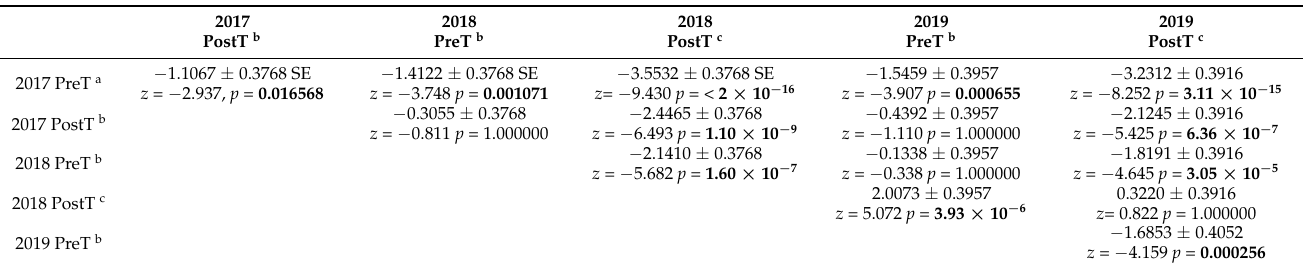
Figure 7. Population trend of the treated pigeon colonies during pre-treatment (PRE-T) and post- treatment (POST-T) periods of the study. Vertical lines indicate standard error; treatment periods with different superscripts (a, b, c) are different ( p < 0.05). Table 3. Results of the post hoc tests (Tukey test) of the registered population trend among treat- ment periods.